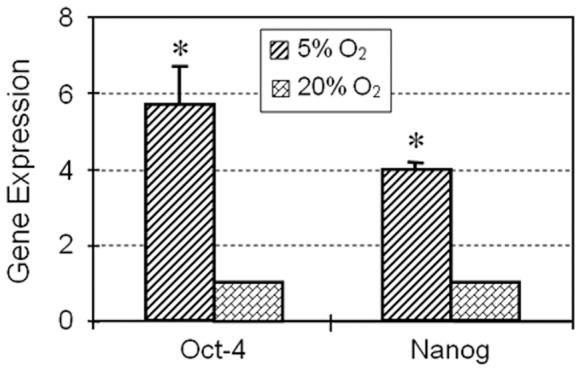
Stem cell gene analysis by qRT-PCR.Total RNA extracted from hTSCs grown under hypoxic or normaxic conditions was used to synthesize cDNA, which was used as a template in qRT-PCR using primers specific to Oct-4 and Nanog. GAPDH was used as an internal control. Y- axis represents relative gene expression when compared to GAPDH expression levels. Ct values were normalized against hTSCs cultured under 20% O2. Both stem cell marker genes (Oct-4 and Nanog) cultured at 5% O2 culture conditions were expressed at significantly higher g005levels than those cultured at 20% O2 culture conditions.